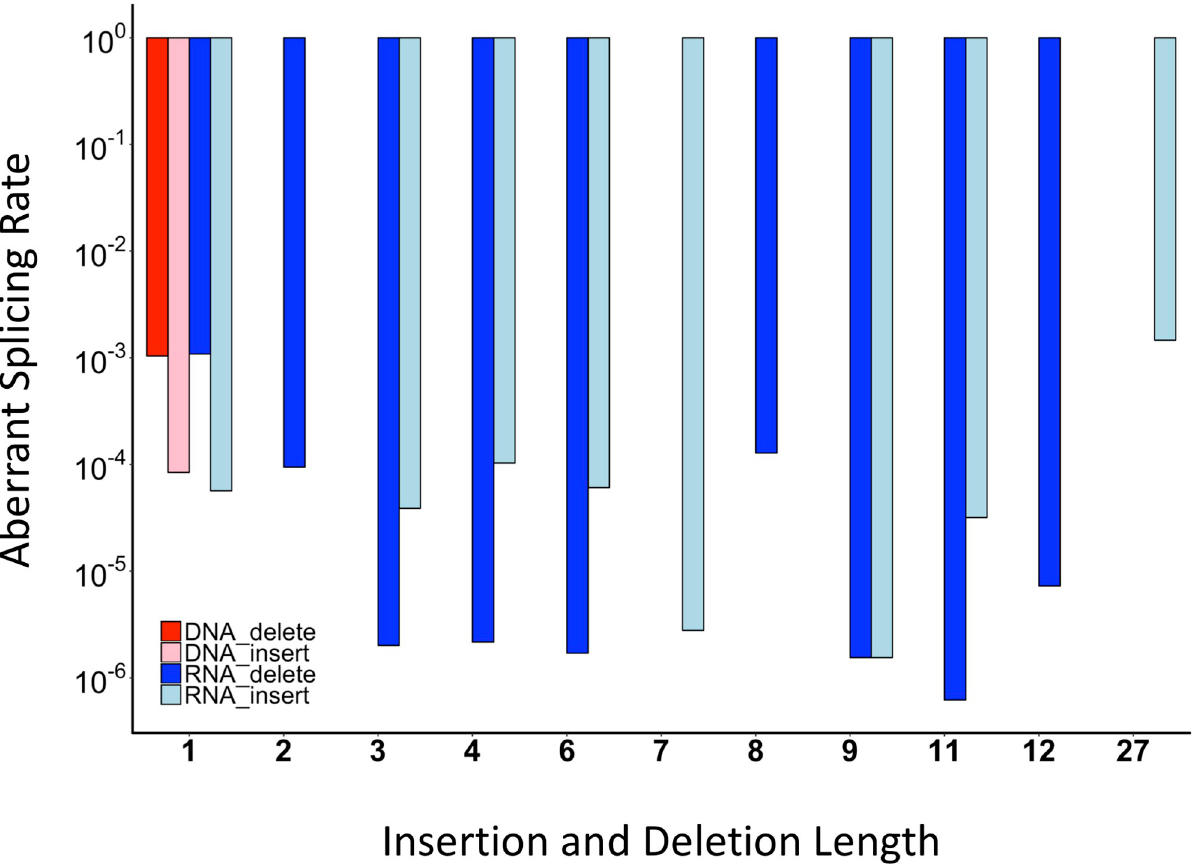
Fig 2. Analysis of aberrant splicing rates in DNA and RNA reads by error length. To detect possible reading frame preservation bias in aberrant splicing events, an analysis of splicing aberrant splicing rates in DNA and RNA by insertion or deletion length in wild-type reads was performed. For example, the insertion of 4 nucleotides GTAA at the 5’SS of exon 7 and the insertion of 4 nucleotides ACAG at the 3’SS of exon 8 are combined as a total aberrant splicing rate for the insertion of 4 nucleotides. There is no consensus error length.